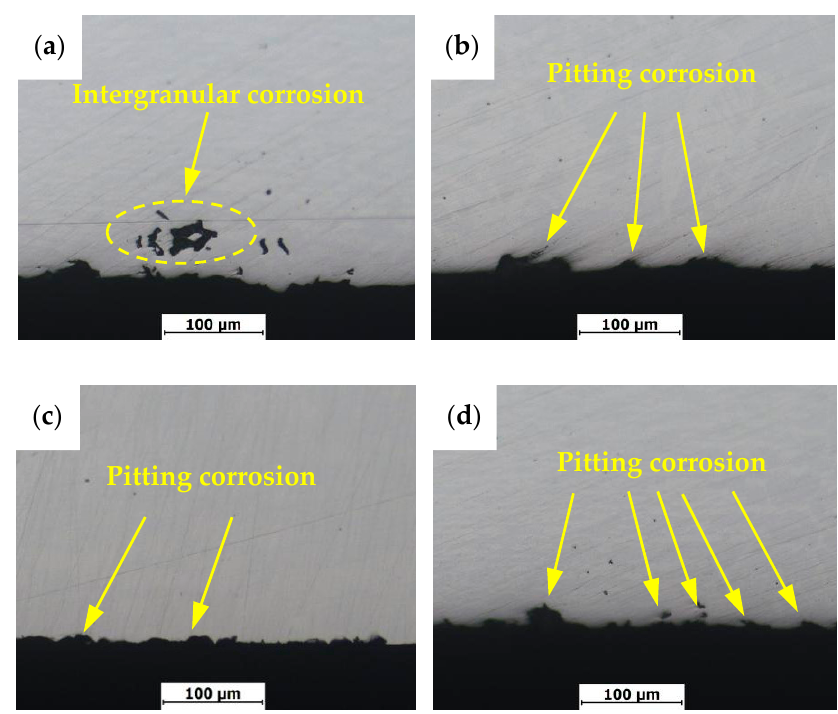
Figure 13. Cross section morphology of intergranular corrosion welded joints with different treatments methods: ( a ) untreated; ( b ) pneumatic chipping hammer; ( c ) ultrasonic peening treatment; ( d ) heat treatment.